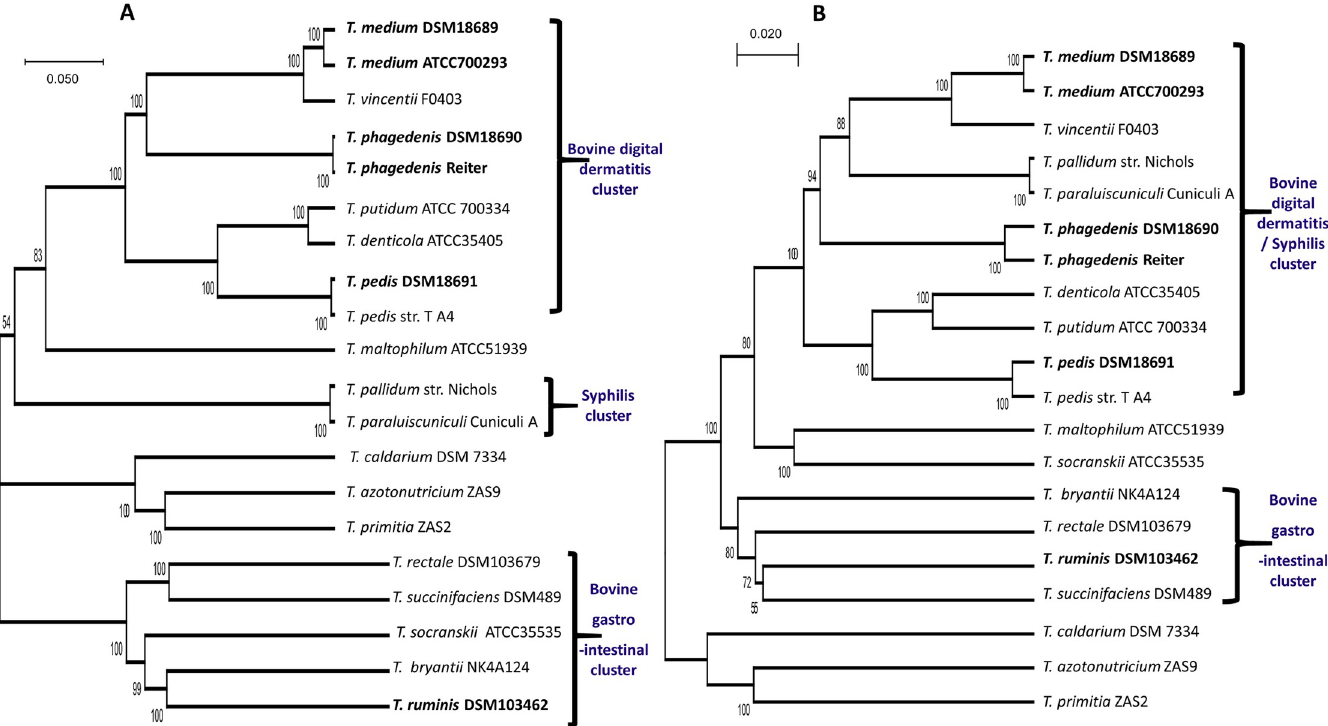
Fig 1. Phylogenetic trees of core and pan genomes from relevant treponemes. A core-genome phylogenetic tree was constructed using protein sequences from 20 random orthologous gene clusters (encoded by ileS, valS, topA, fusA, fusA-2, tpiA, dnaK, lepA, atpA, fliI, flgE, eno, atpB, clpX, metK, dnaJ, ruvB, and uncharacterised genes corresponding to T . denticola ATCC35405 genome loci TDE0714 and TDE1969, with a total concatenated size of 36.12kb) aligned in MUSCLE [87], and subjected to the unweighted pair group method with arithmetic mean (UPGMA) algorithm and the Jones-Taylor-Thornton (JTT) model with 10,000 bootstrap replicates [88] ( A ). A pan-genome phylogenetic tree was reconstructed using UPGMA algorithm and the Jukes-Cantor model with 10,000 bootstrap replicates [88] using a binary presence/absence gene pan matrix produced from BPGA representative of 23,260 genes [75] ( B ).